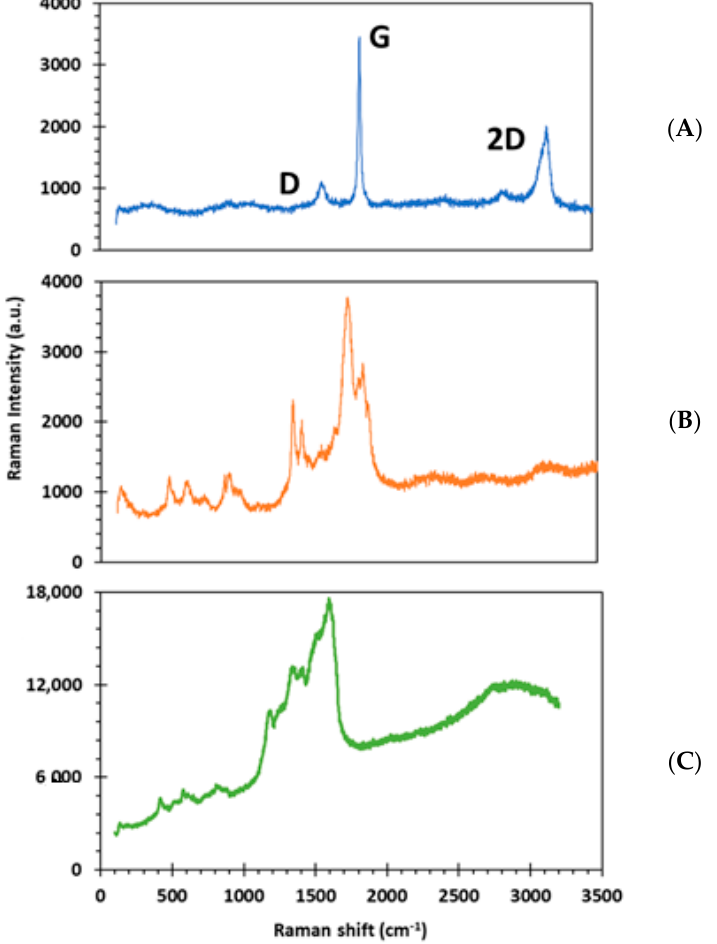
Figure 2. Surface chemistry using Raman ( A ) control graphene, ( B ) graphene and PANI and ( C ) graphene, PANI and anti- cortisol.